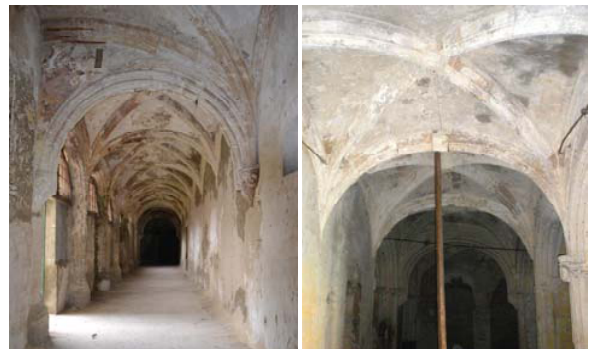
Figure 3: Detail of the western side and interior of the eastern one facing the